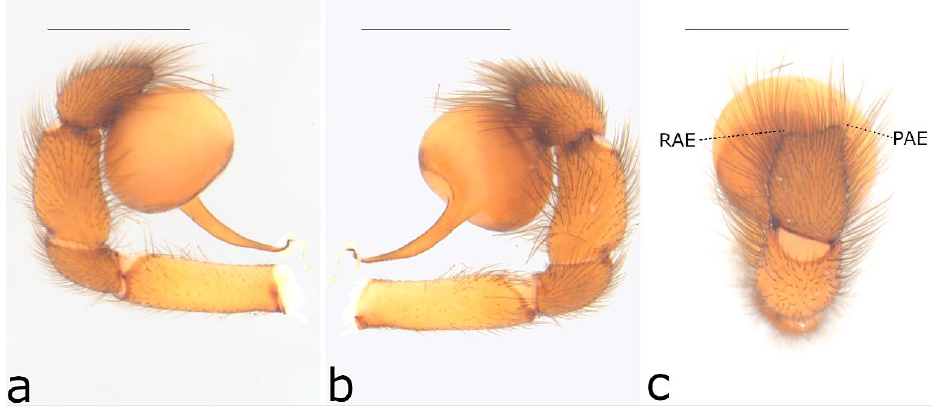
Figure 27. Ariadna arenacea sp. nov. ♂ holotype (SAMA NN30585) from north Wartaru (SA): ( a ) left ♂ pedipalp, prolateral view; ( b ) same, retrolateral view; ( c ) same, cymbium. Scale bar = 1 mm.